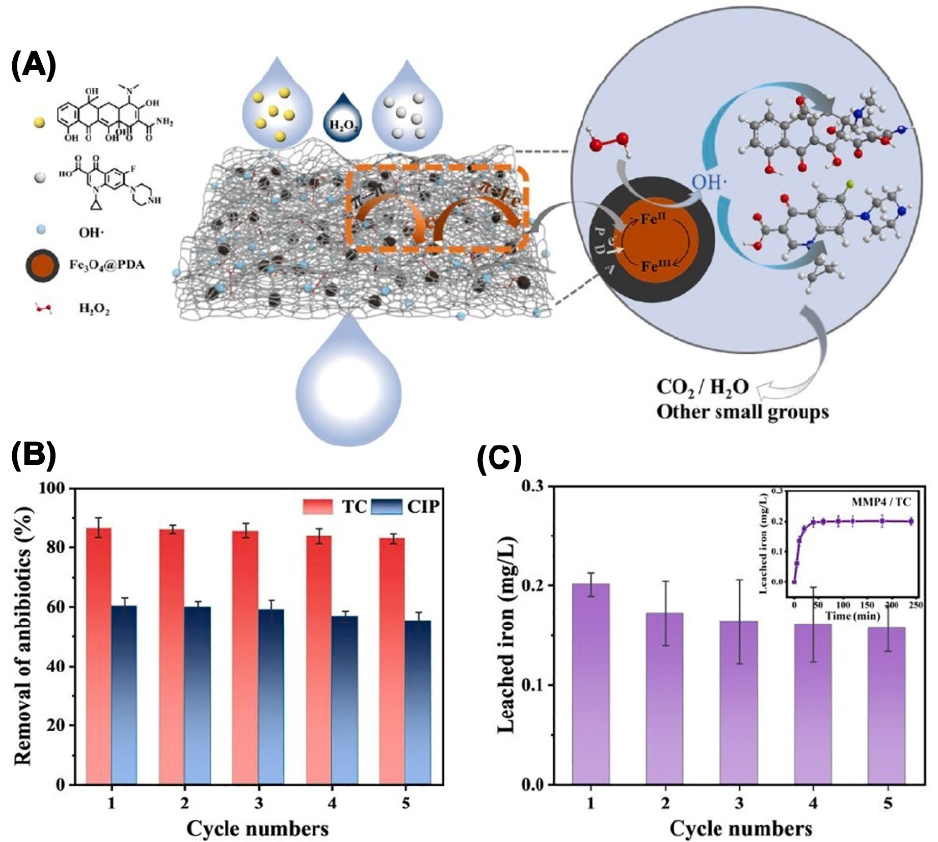
Figure 6. ( A ) Schematic illustration of H 2 O 2 activation and TC degradation in the MMP 4 /H 2 O 2 Fenton-like system; ( B ) Removal efficiency of TC and ( C ) leached iron in five consecutive runs (inset shows the kinetics of leached iron in the first cycle) [85], Copyright 2021 Elsevier.